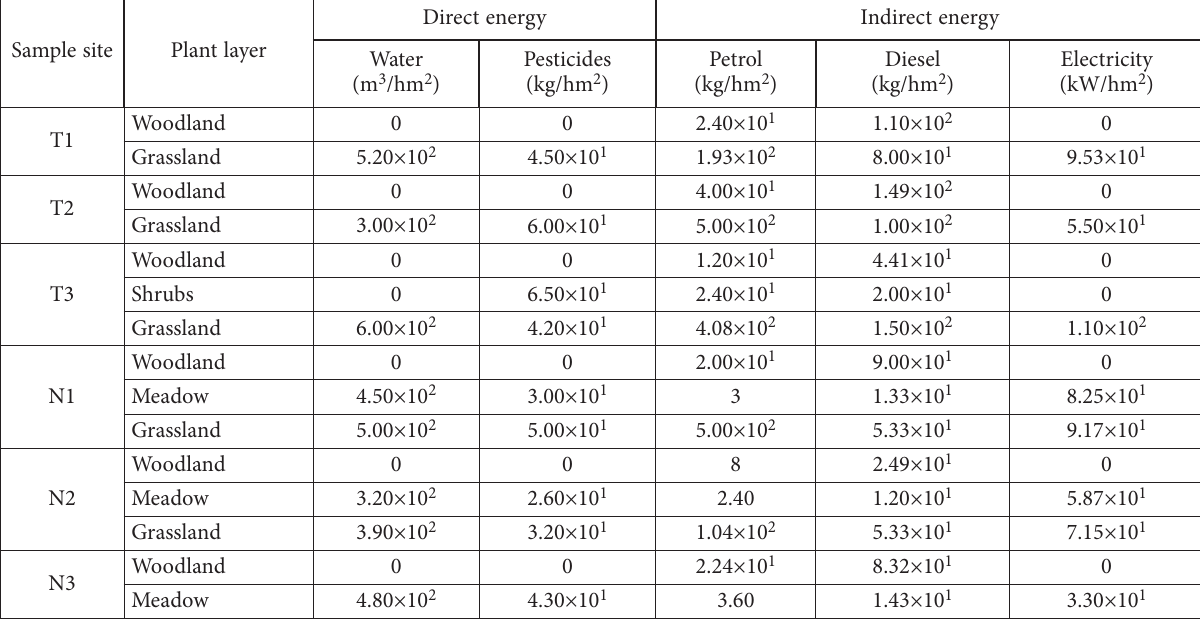
Table 3. Inventory of the material input for site maintenance